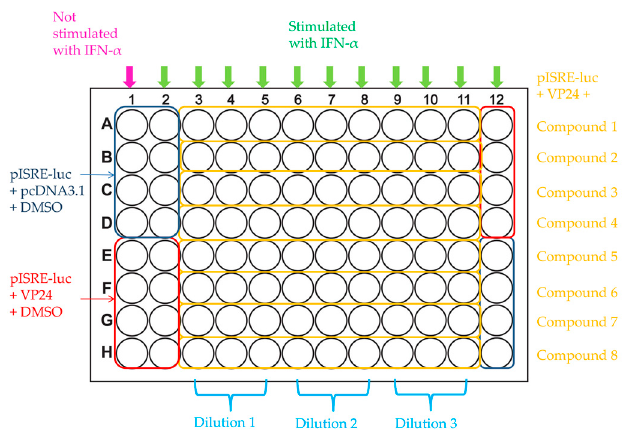
Figure 6. Representative scheme of 96 ‐ well plate for drug screening.